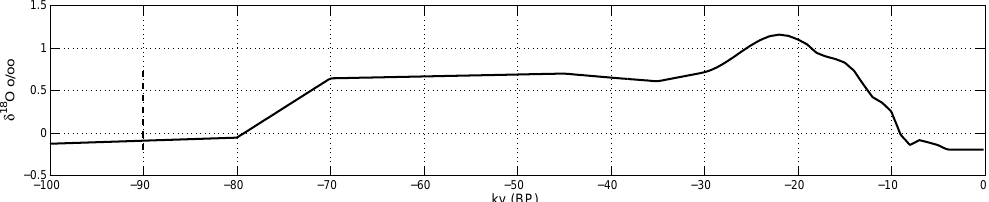
Figure 1. Prior estimate of the ocean–sediment interface boundary condition on δ 18 O w , derived from the sea level curve of Miller et al. (2015). The maximum a priori value for the LGM is 1.15 ± 1‰ and the minimum, calculated very approximately from the data in Fig. 2 is − 0.2 ± 1‰, consistent with previous such estimates in the references (e.g. Miller et al., 2015). Time zero for integrations starts at − 100ky. Vertical dashed line indicates a range of 1‰ between the nominal modern value and the change to the LGM described by Schrag et al. (2002).